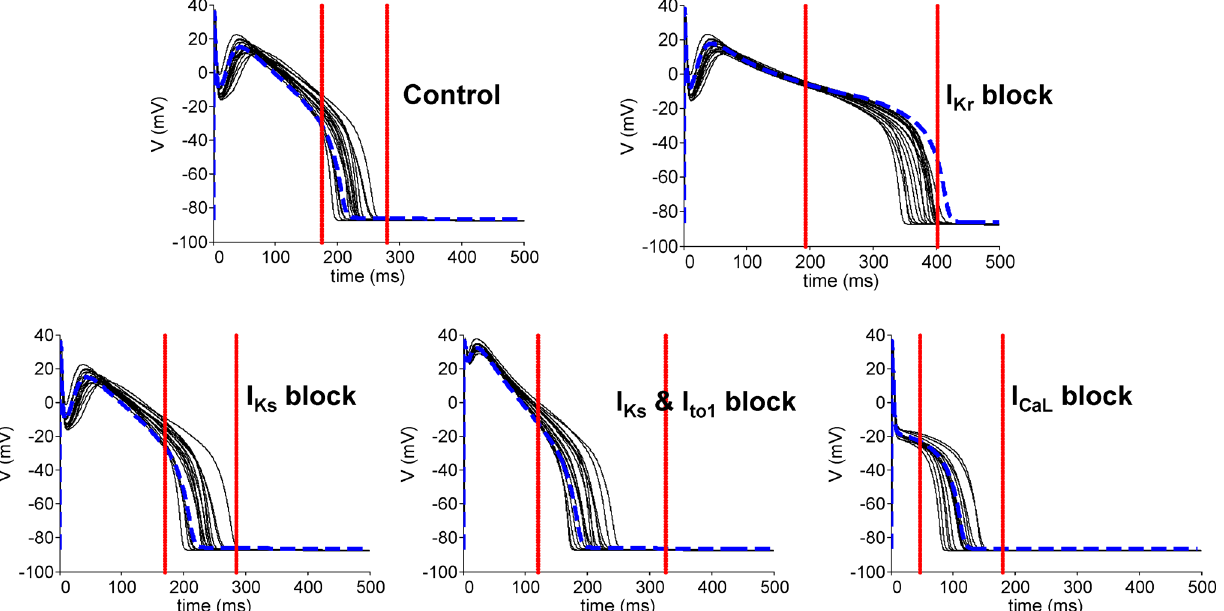
Fig 2. Deterministic model single AP traces. Single AP traces obtained using the seventeen deterministic models, simulated with a BCL of 1000 ms under: control conditions (top left), complete I Kr inhibition (top right), complete I Ks inhibition (bottom left), complete I Ks and 90% I to1 inhibition (bottom middle) and 95% I CaL inhibition (bottom right). Red vertical lines represent the maximum and minimum APD values derived from experimental data for the same simulation protocol. The blue dotted AP trace represents the Decker model without any rescaling of the ionic currents.